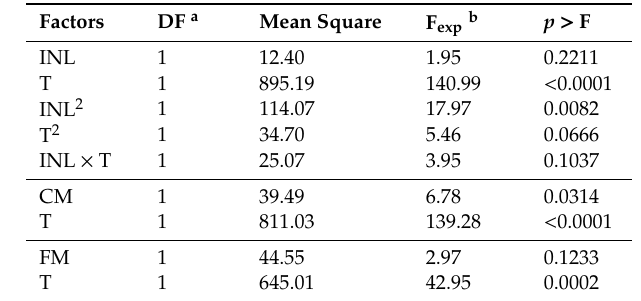
Table 3. Summary of ANOVA for the overall e ff ects of chia seed mucilage (CM), flaxseed mucilage (FM), or inulin (INL) concentration in the encapsulating solution and drying inlet air temperature (T) on the survival of the L. rhamnosus after spray drying.